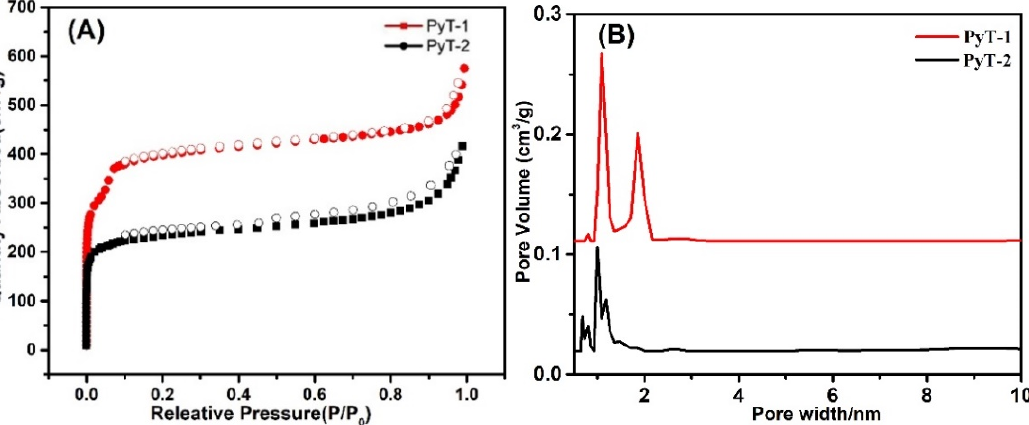
Figure 4. N 2 -capture desorption isotherms of PyT-1 and of PyT-2 ( A ); pore size distribution of PyT-1 and of PyT-2 ( B ).